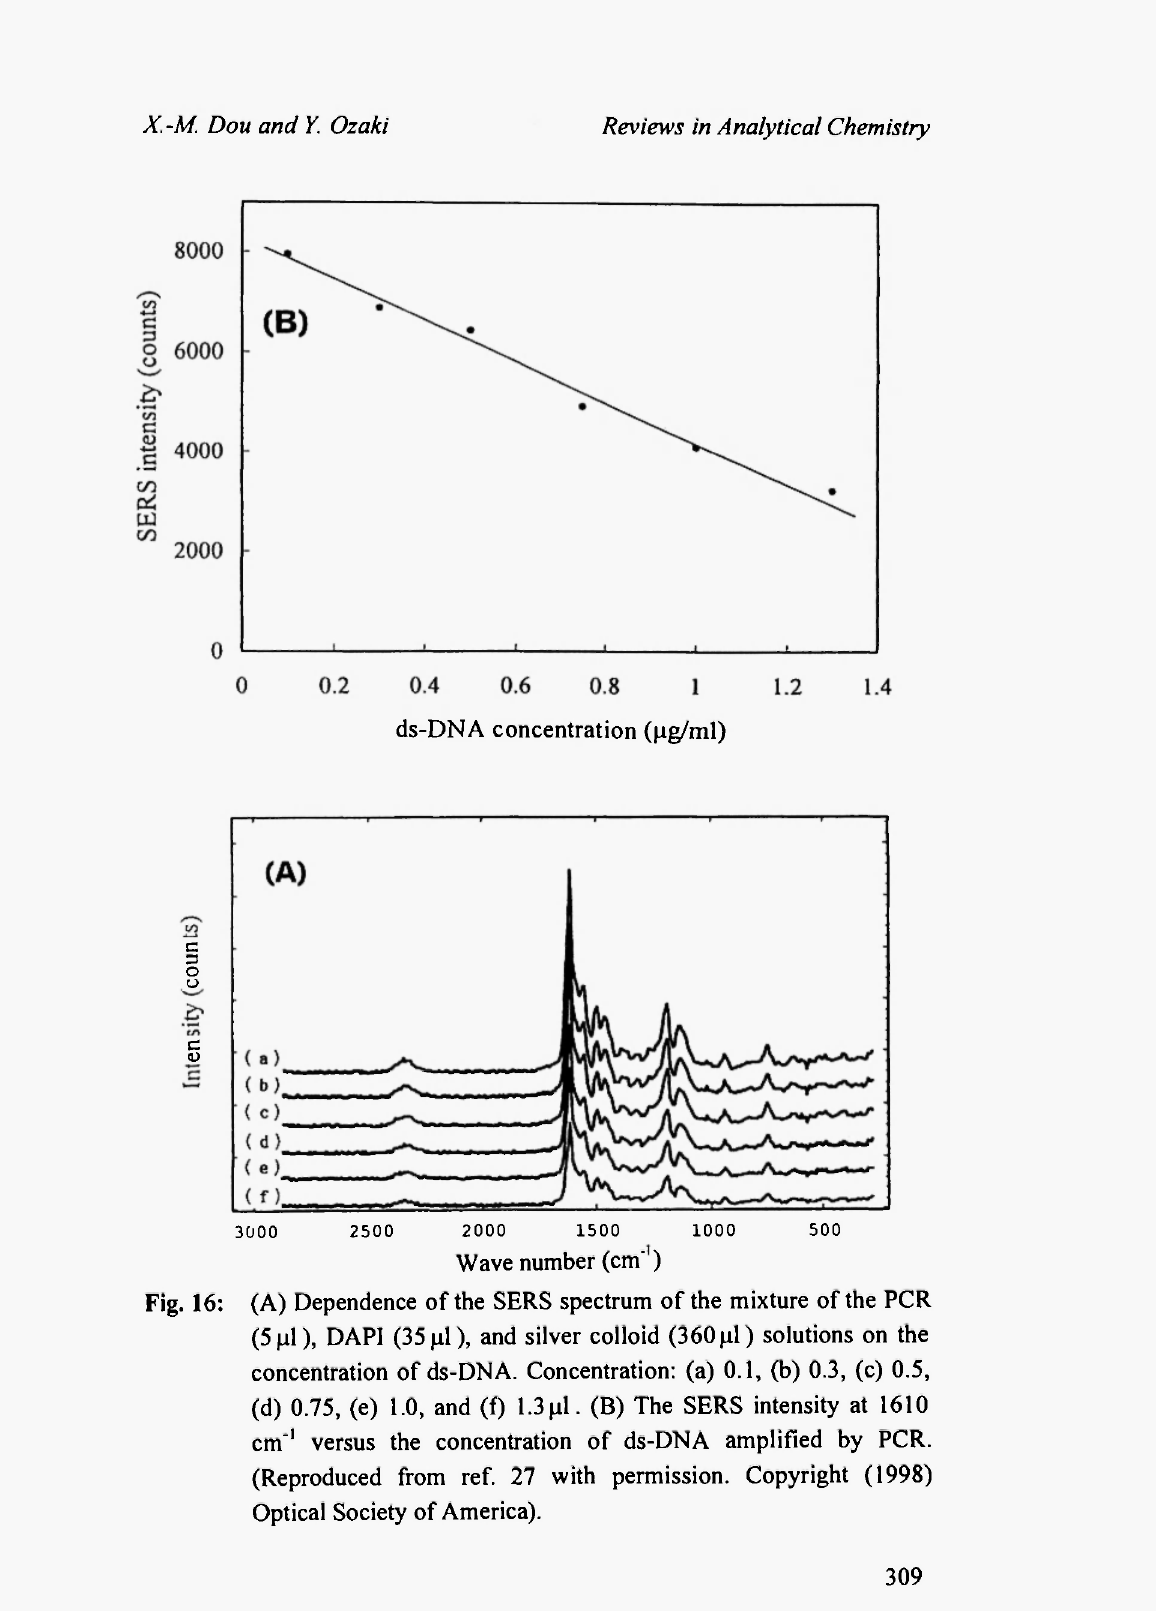
(A) Dependence of the SERS spectrum of the mixture of the PCR (5 μΐ), DAPI (35 μΐ), and silver colloid (360 μΐ) solutions on the concentration of ds-DNA. Concentration: (a) 0.1, (b) 0.3, (c) 0.5, (d) 0.75, (e) 1.0, and (f) 1.3 μΐ. (Β) The SERS intensity at 1610 cm" 1 versus the concentration of ds-DNA amplified by PCR. (Reproduced from ref. 27 with permission. Copyright (1998) Optical Society of